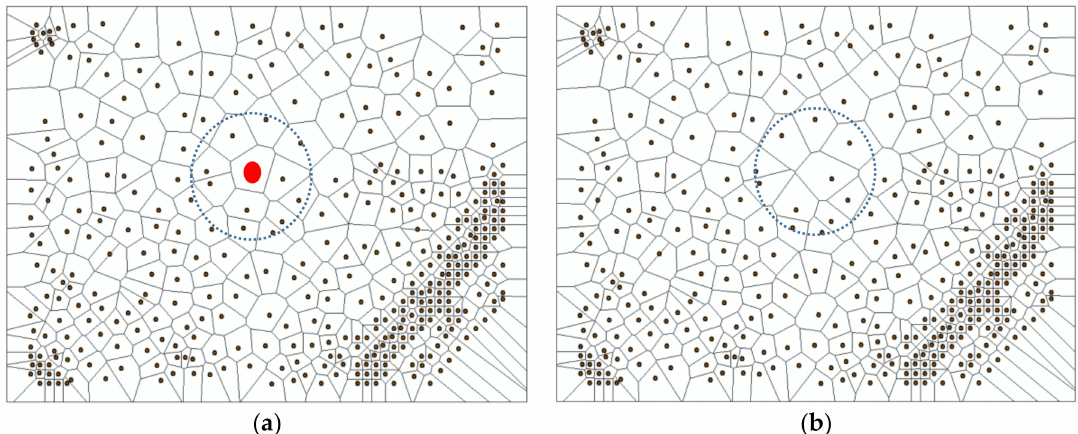
Figure 2. Voronoi diagram behavior when a sensor changes the status. ( a ) Voronoi diagram of the sensor network in active mode. ( b ) The Voronoi diagram in sleep